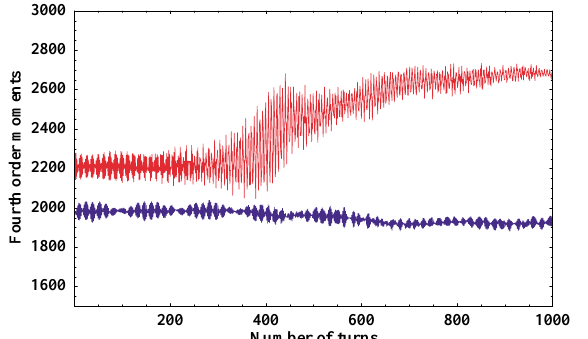
FIG. 5. (Color) Time evolution of (cid:5) x 4 (cid:6) (blue) and (cid:5) y 4 (cid:6) (red) for (cid:1) n (cid:2) (cid:1) (cid:1) 5.82, 5.79 (cid:2) in normalized units. x , n y